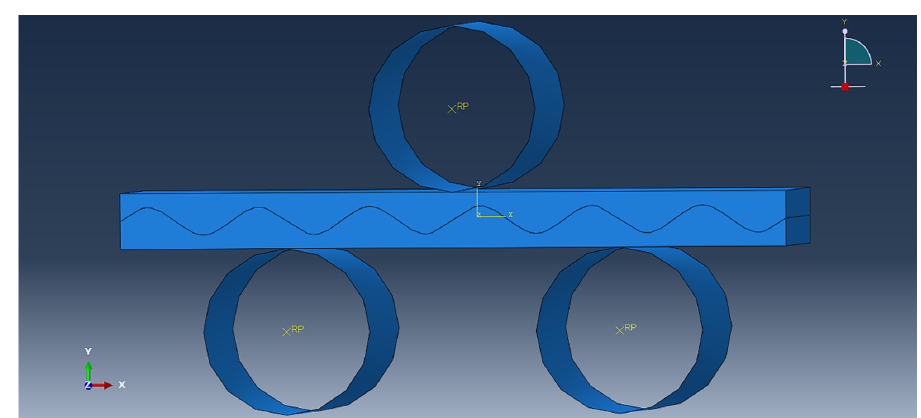
Figure 5. Schematic diagram of single straightening unit of composite plate. Table 2. General parameters of straightener.